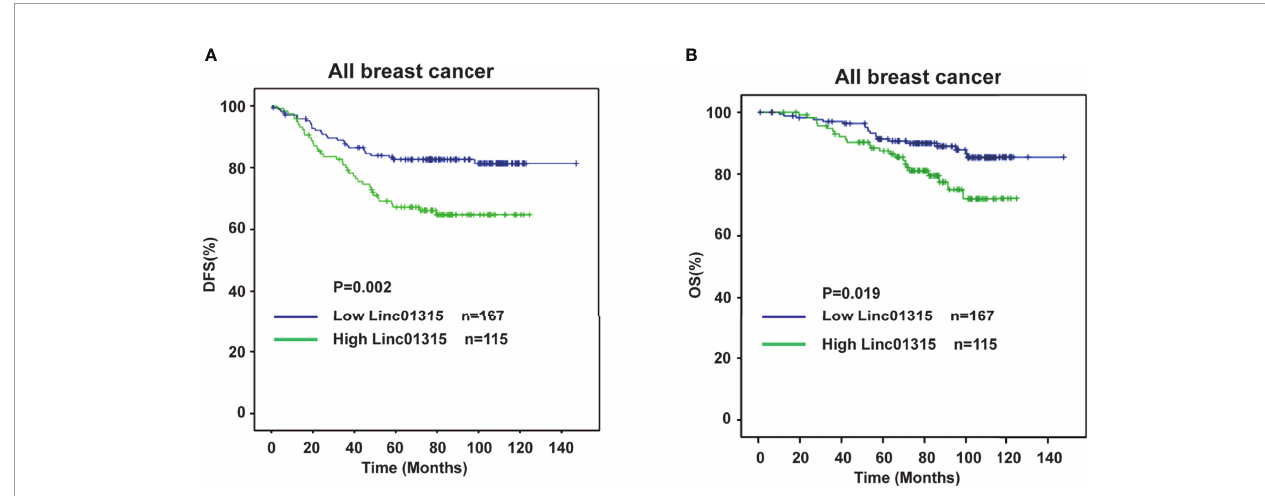
FIGURE 2 | Low expression level of Linc01315 correlates with higher disease free survival (DFS) and overall survival (OS). (A) Kaplan-Merier curves of 282 breast cancer patients after strati fi cation by the level of Linc01315 were used for depicting Disease-free survival (DFS). (B) Kaplan-Merier curves of 282 breast cancer patients after strati fi cation by the level of Linc01315 were used for depicting Overall survival (OS).